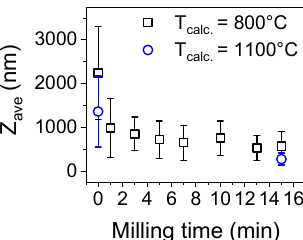
Figure 5. Particle diameter (expressed in cumulants mean—Z-ave) of yttria powder obtained by the SCS method.